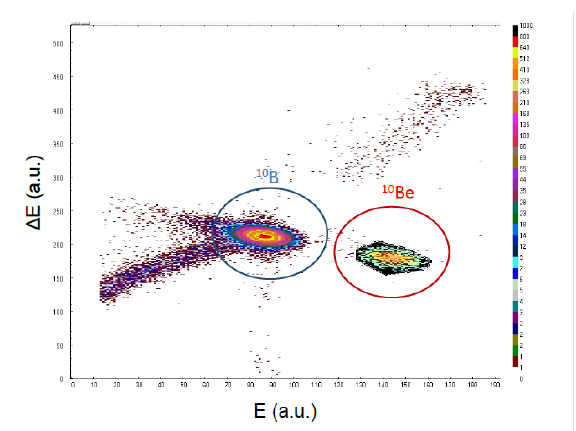
Figure 6. ∆ E-E spectrum from BeO samples irradiated with neu- trons to produce 10 Be. The circles show the well separation be- tween 10 Be events and those of its isobar, the 10